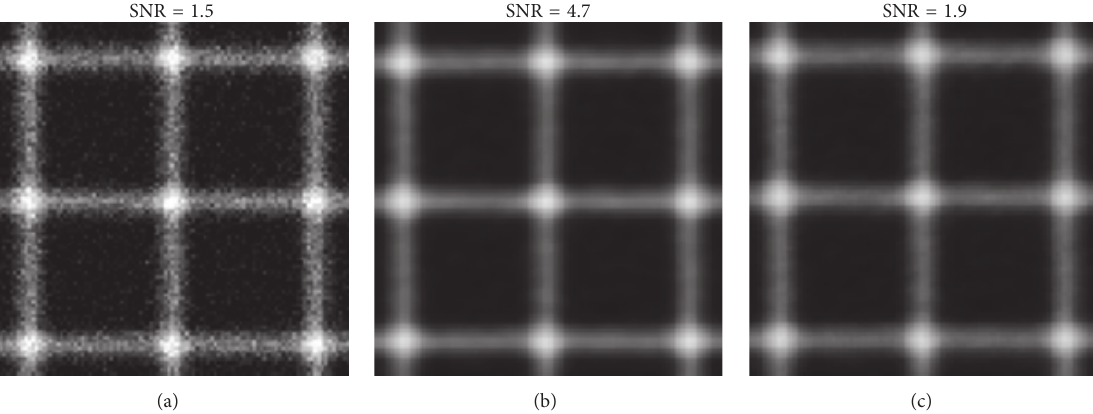
Figure 4: (a) Original image, (b) filtered image after applying the Gaussian filter, and (c) mean-filtered image. Here LW = 9 pixels.